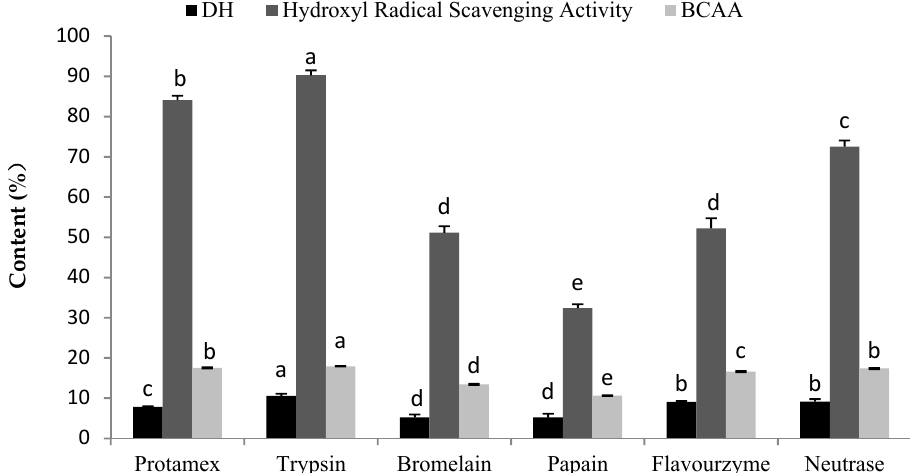
Figure 1. DH, hydroxyl-radical-scavenging activity, and BCAA contents of hydrolysates produced by various proteases. DH indicates the degree of hydrolysis; BCAA indicates branched-chain amino acids. The concentration of hydrolysates was 10 mg/mL in the hydroxyl-radical-scavenging activity assay. Different letters indicate significant differences between groups ( p < 0.05).